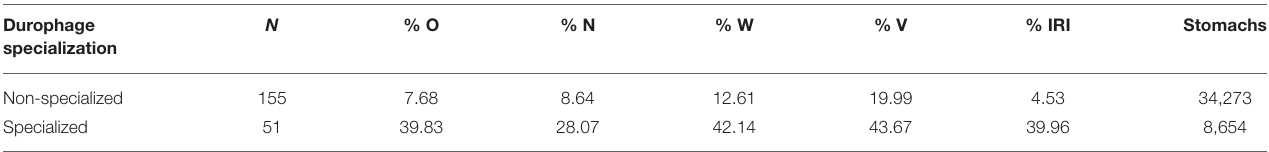
TABLE 1 | Summary of average quantitative diet information for the 206 fish species exhibiting durophagy within our dataset derived from our literature survey. Durophage